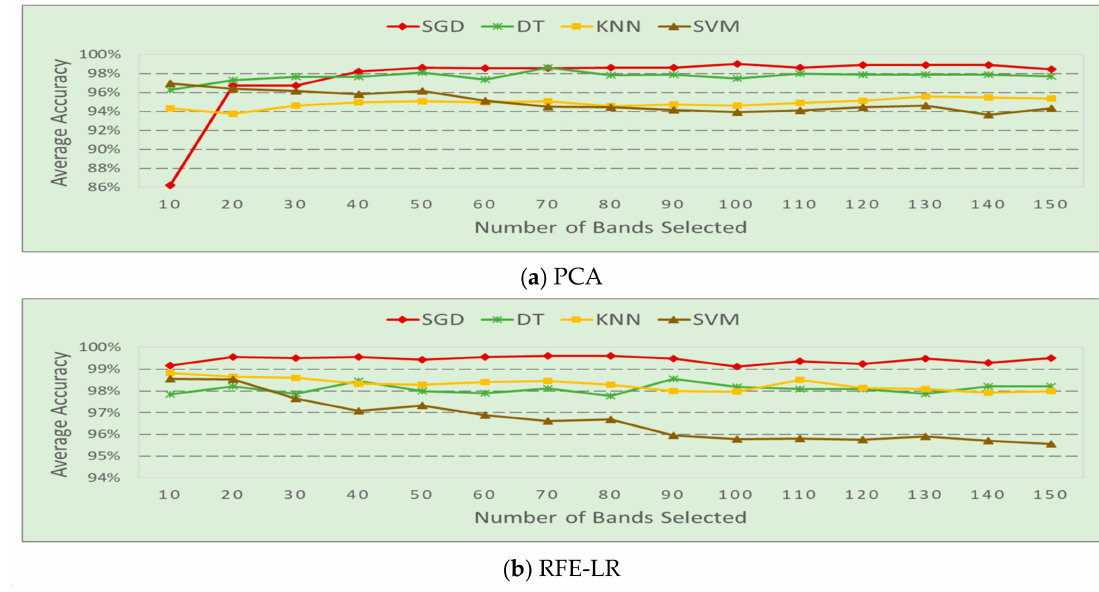
Figure 5. Average accuracy vs. the number of frequency bands